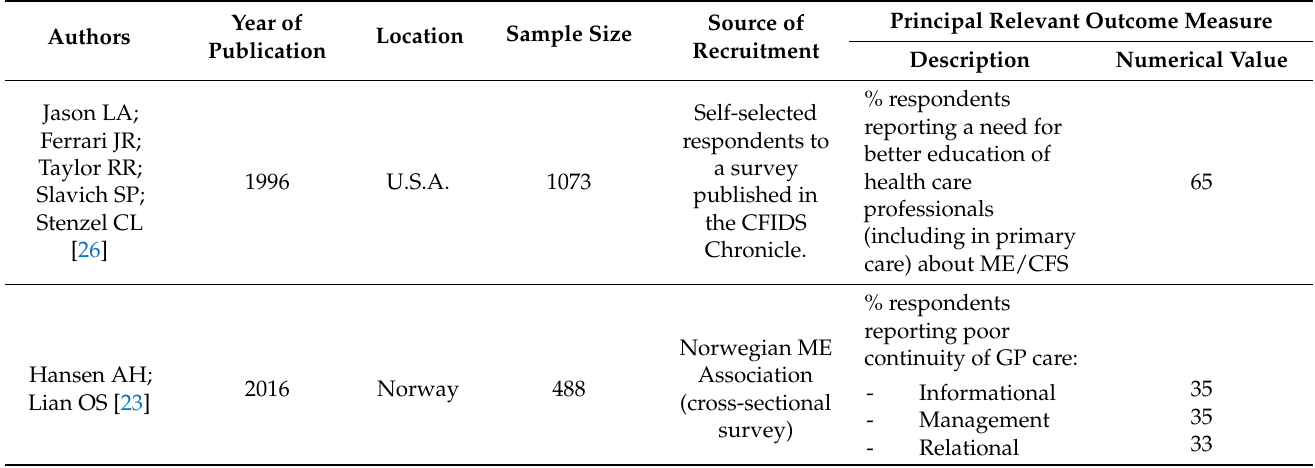
Table 5. Patients’ opinions about GP care of people with